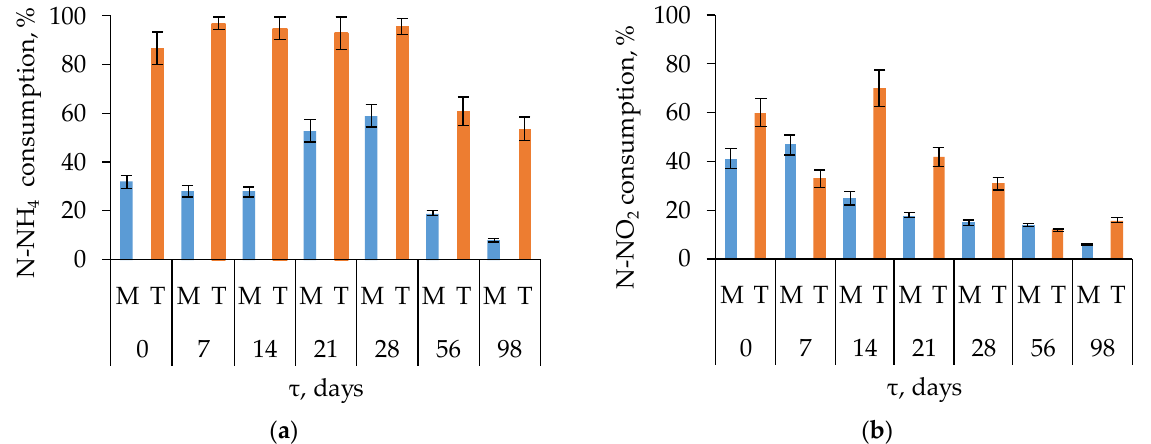
Figure 4. Dynamics of nitrifying activity: ( a ) stage I nitrifying microorganisms according to the ammonium consumption; ( b ) stage II nitrifying microorganisms according to the nitrite consumption isolated at the onset of composting (0) and on days 7, 14, 21, 28, 56, and 98 of composting; M, mesophilic microorganisms; T, thermophilic microorganisms.